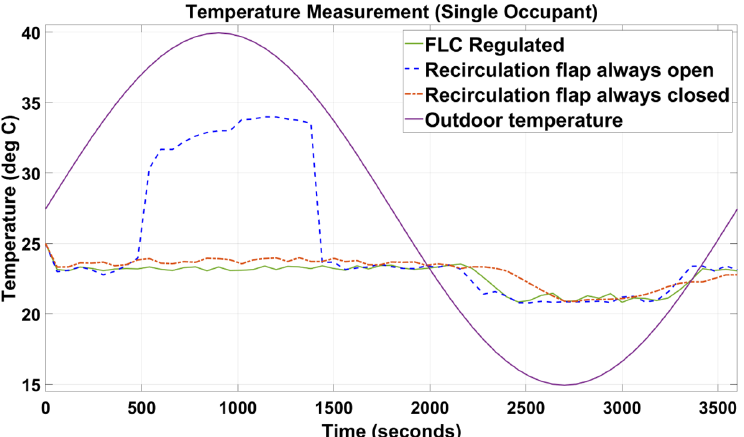
Figure 6. PMV index of the simulated vehicle cabin with three occupants.